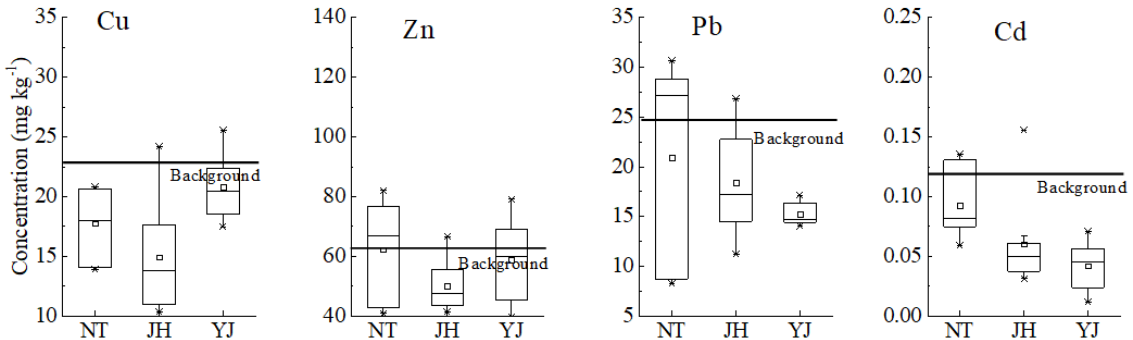
Figure 4. Heavy metal concentrations at the depth of 90–100 cm in highway-side soils and the corresponding background values. (The black bold lines are the background values of corresponding elements. NT, Ningtong expressway; JH, Jinghu expressway; YJ, Yanjiang expressway. The interquartiles from bottom to top in the box are 25%, 50% and 75% of the data, respectively. The small square is the average value. The two endpoints of the bar are minimum and maximum values, respectively. The asterisks are the outliers.)